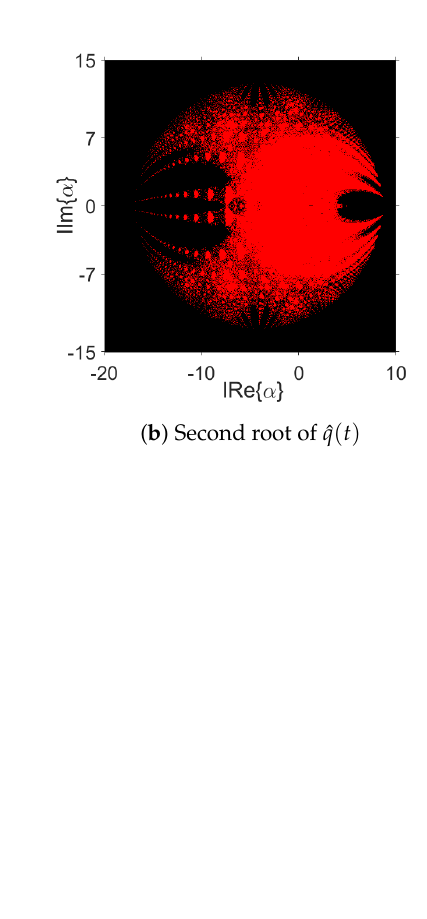
Figure 2. Parameter planes of O γ ( z ) .